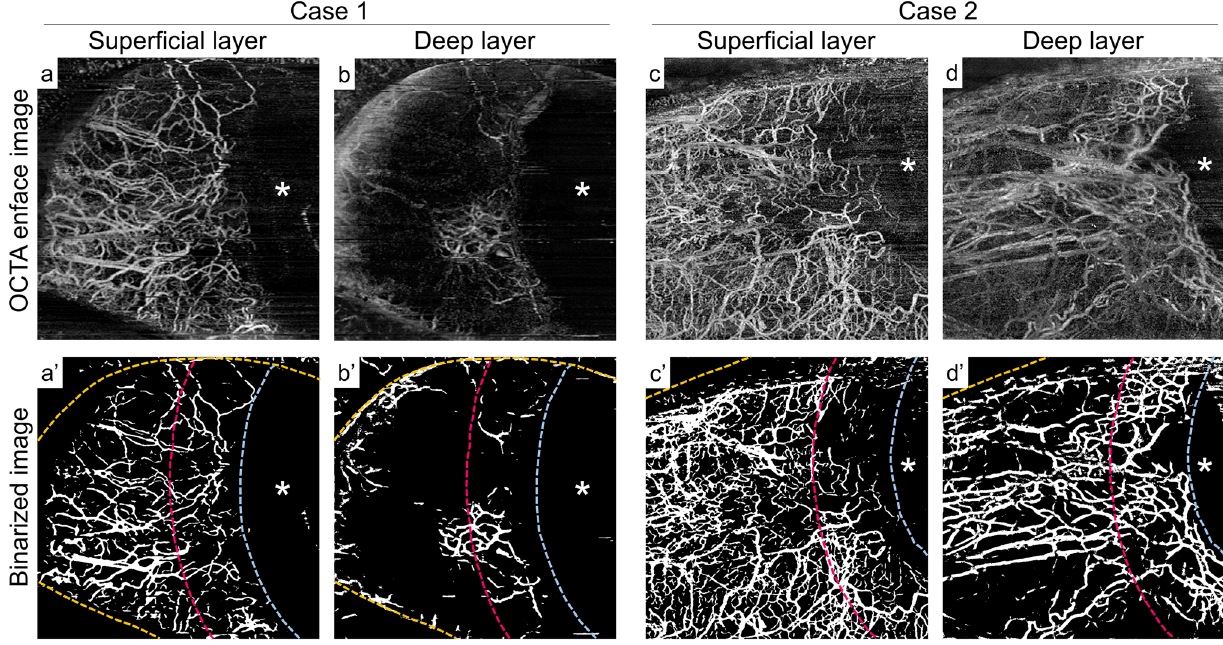
Figure 1. Representative anterior segment (AS) optical coherence tomography angiography (OCTA) images. ( a,b ) AS-OCTA images of a left eye in the successful group (case 1). ( c,d ) Mirror-reversed AS-OCTA images of a right eye in the unsuccessful group (case 2). ( a ′ –d ′ ) The binarized images of ( a – d ). The aqua dotted line is the boundary of the corneal limbus, and the red dotted line is the boundary between the limbal and fornix areas. The orange dotted lines are the eyelid margins. The flow signals in the deep layer are rich in the limbal area, although there are fewer in the fornix area ( b , b ′ ); however, flow signals in the deep layer are abundant in the fornix area as well as in the limbal area ( d , d ′ ). Asterisks indicate the location of the